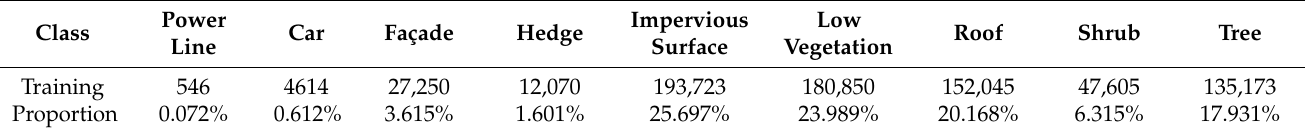
Table 2. Details of training data